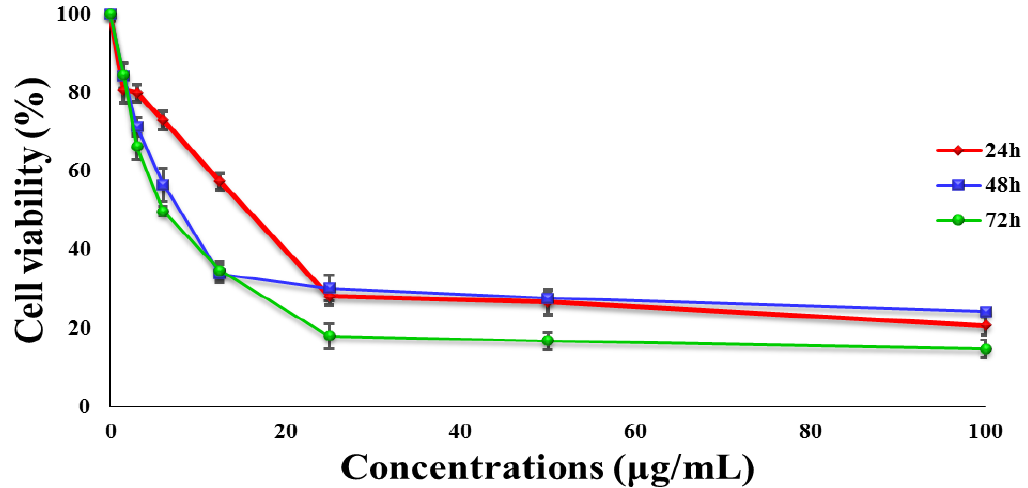
Figure 1. The tested agent induced cell cytotoxicity on MCF7 cells in a time-dependent manner. The IC value of TPHE at 24, 48 and 72 h on the MCF7 cell line was determined 50 to be 24.65 ± 2.41, 6.42 ± 0.35 and 5.16 ± 1.6 μ g/mL, respectively. The data are shown as the mean ± SD ( n = 3).